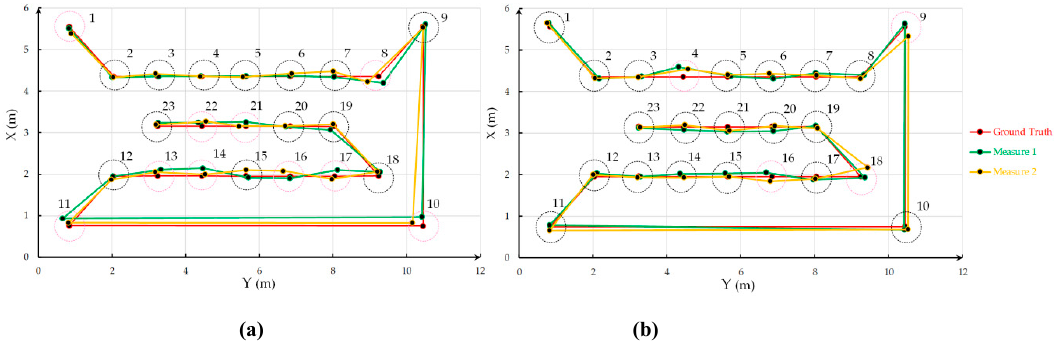
Figure 16. Positioning result co-ordinate offset in Room 212: (a) Samsung and (b) Huawei smartphones.